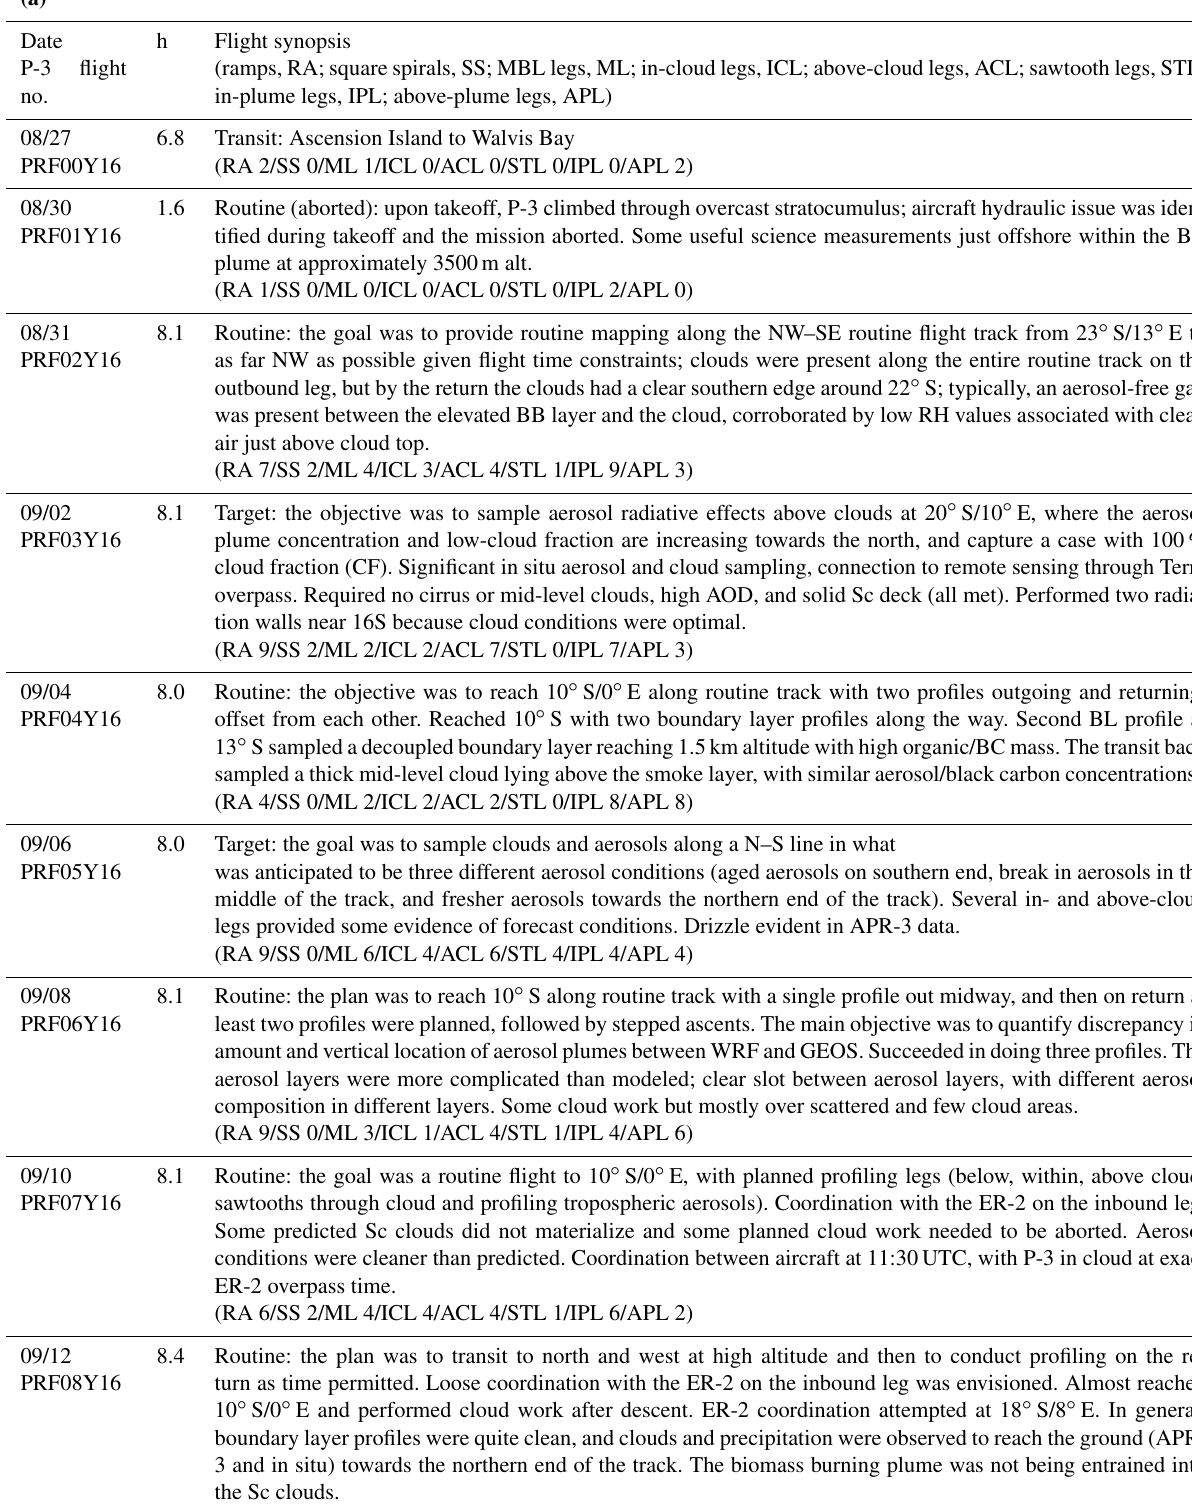
Table A1. (a) The 2016 flight summary for the P-3 aircraft. The number of each type of flight maneuver (as given in the table header) is shown in parentheses for each flight. Flight synopsis indicates whether the flight was a designated routine or target-of-opportunity flight. (b) The 2016 flight summary for the ER-2 aircraft. (a) Date